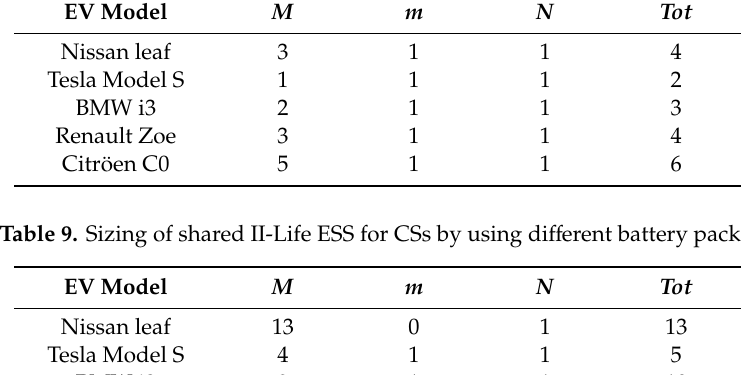
Table 8. Sizing of dedicated II-Life ESS for CSs by using di ff erent battery packs. EV Model